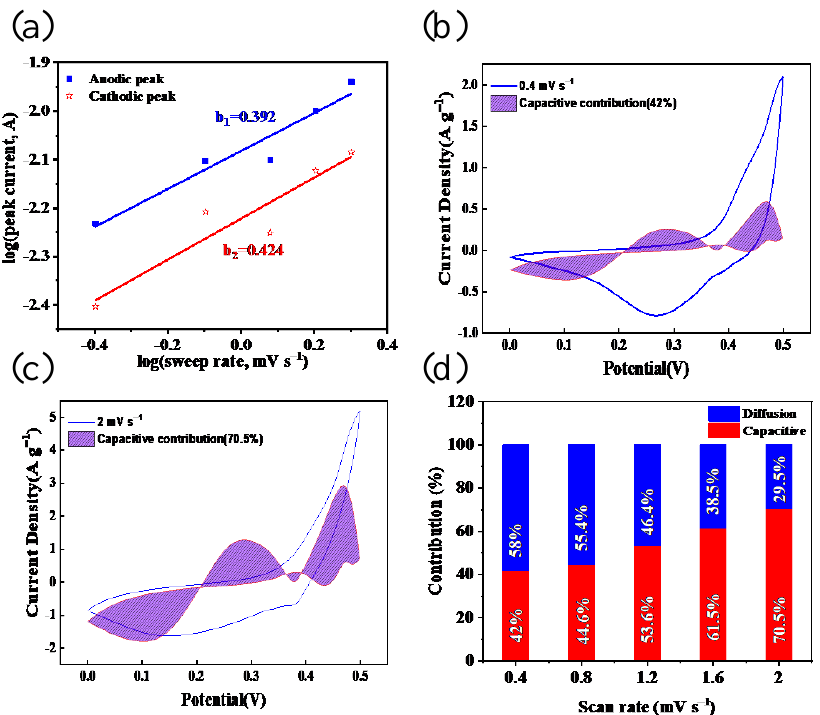
Figure 8. ( a ) Relationship between peak current and scan rate. Capacitance ratio fitting and CV curves of NiCoFe–LDH/V 2 CT x –MXene composites at ( b ) 0.4 and ( c ) 2 mV s − 1 . ( d ) Normalized contribution of the capacitance and diffusion control capacitance at different scan rates.